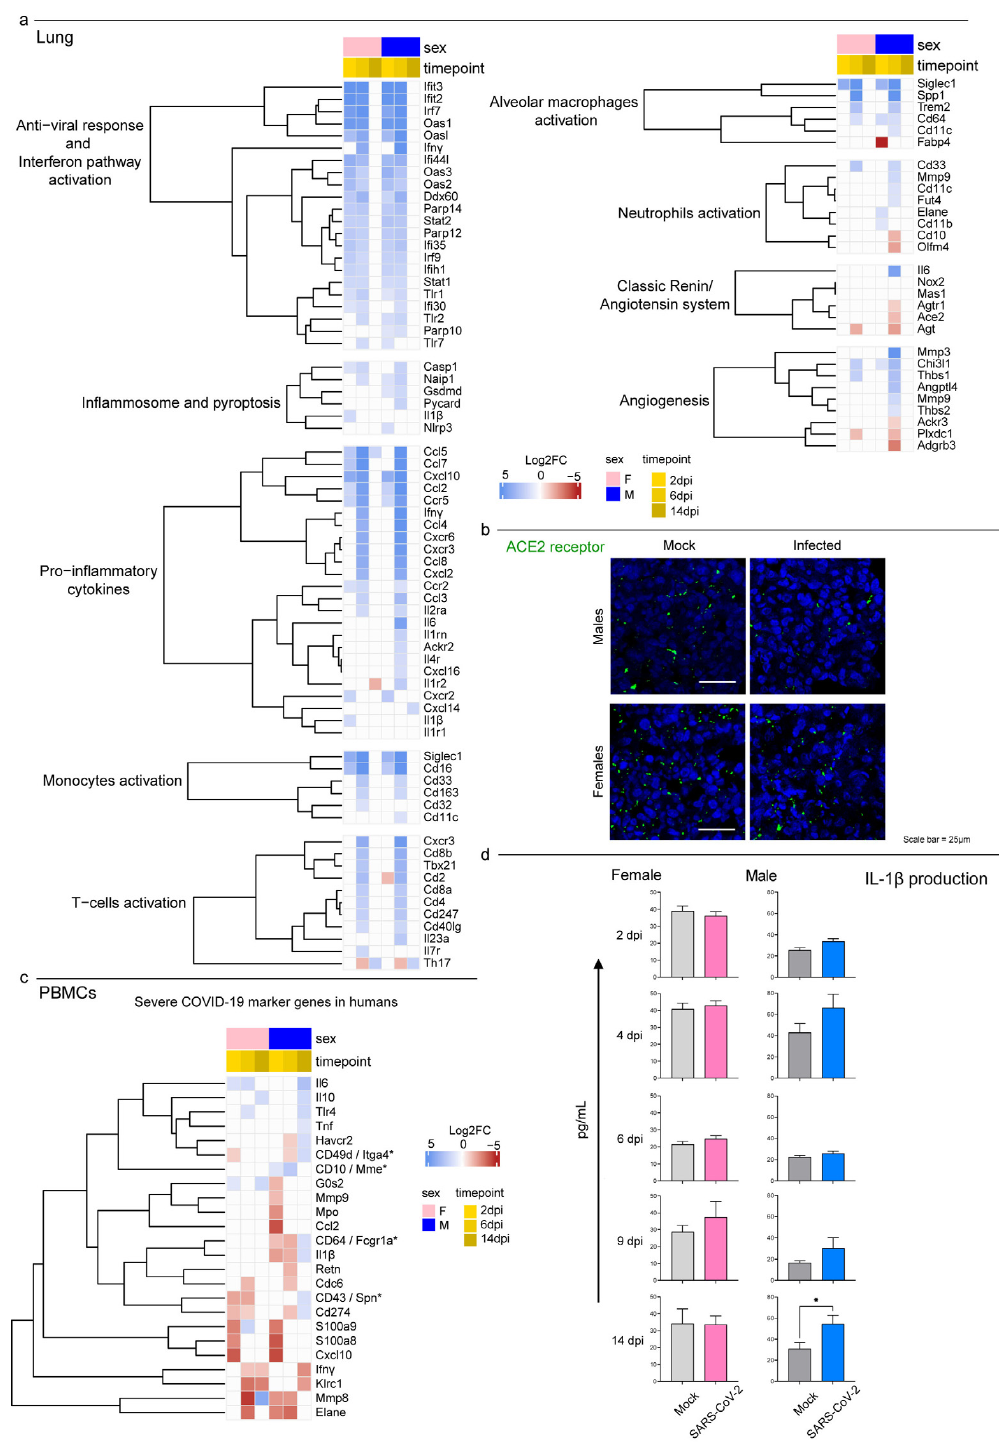
Figure 6. Transcriptomic analysis highlighted differences in males’ and females’ systemic responses to SARS-CoV-2 infection. ( a ) Heatmap (Log2FC values of the performed comparisons) of selected genes related to the immune system in the lungs. A DEG was significant in a comparison when Log2FC ≤ − 1 or Log2FC ≥ 1and FDR < 0.05. ( b ) Immunofluorescence staining for the SARS-CoV-2 receptor ACE2 in infected and control male and female lungs at 6 dpi. All animals were analyzed; representative images are shown. Scale bar = 25 µm. ( c ) Heatmap (Log2FC values of the performed comparisons) of selected genes related to the immune system in the PBMC transcriptome. Note: * indicates the gene name for hamsters in case it differed from the human ortholog. ( d ) Singleplex ELISA levels of IL-1 β (pg/mL) for mock and infected male and female hamsters. Wilcoxon–Mann– Whitney tests of mock or SARS-CoV-2-infected males vs. females; mean ± SEM is represented (* indicates a statistically significant comparison).